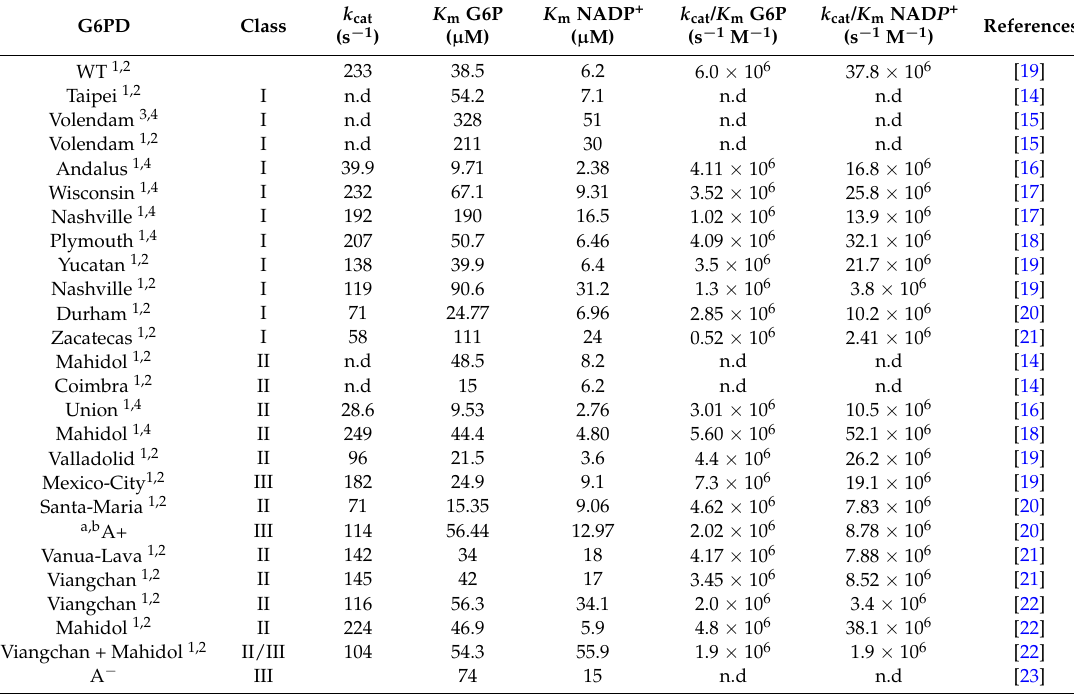
Table 3. Summary of catalytic properties of human recombinant G6PDs proteins.